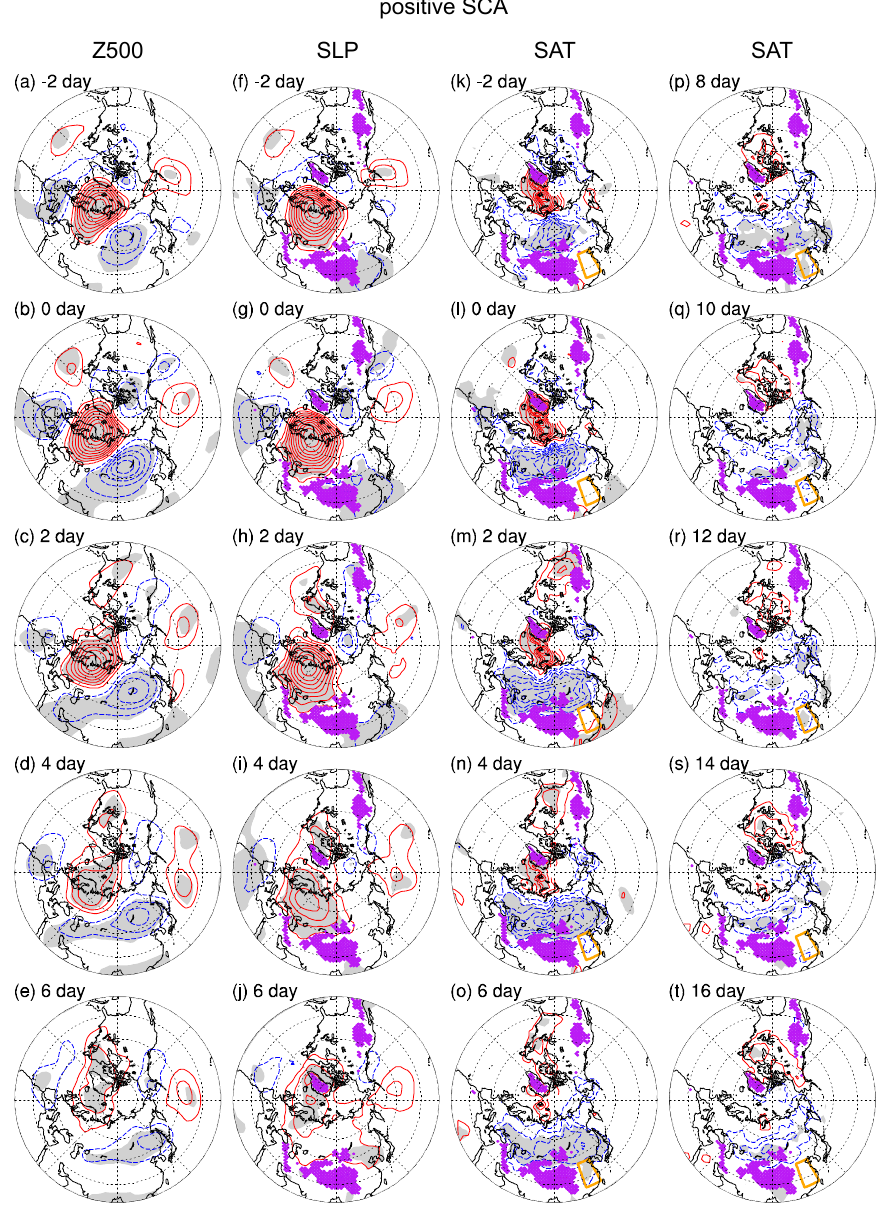
Figure 6. (a – o) Same as subfigures (a – o) of Figure 4, respectively, but for 61 positive SCA events; (p – t) the fourth column is composite SAT anomalies from day 8 to day 16, with an interval of 2 days, for 61 positive SCA events. Days relative to peak days of positive SCA events are indicated in the top left of each panel. Threshold values for the significance level p ∗ are 0.005, 0.003, and 0.003 for the FDR composites of anomalous Z500, SLP, and SAT, respectively.